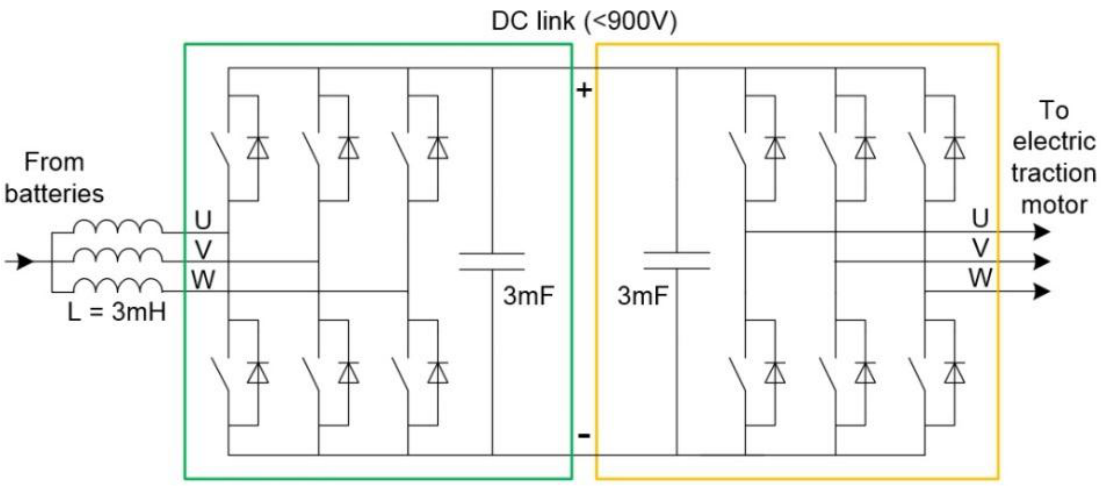
Figure 4. Power electronics topology (simplified